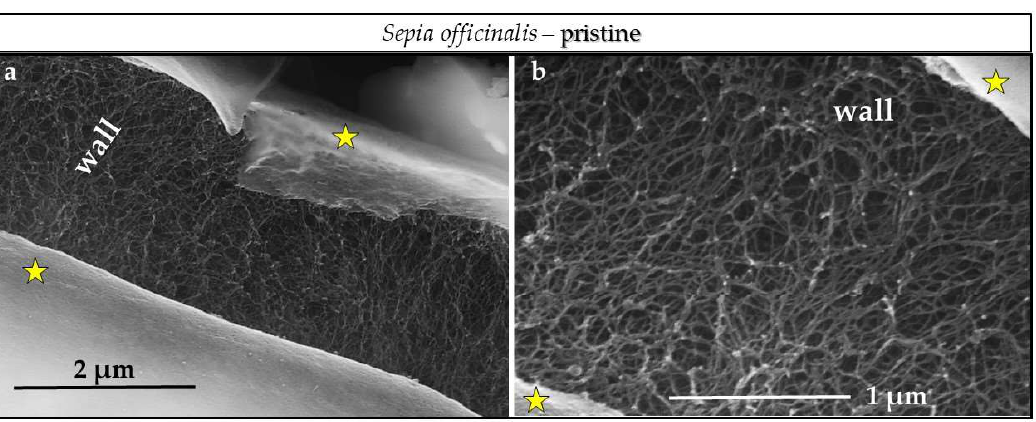
Figure A16. FE-SEM images of the biopolymer network that is occluded within the walls of the cuttlebone of Sepia officinalis . Yellow stars in ( a , b ) point to the protruding biopolymer membranes that line all outer surfaces of all structural elements within the cuttlebone.